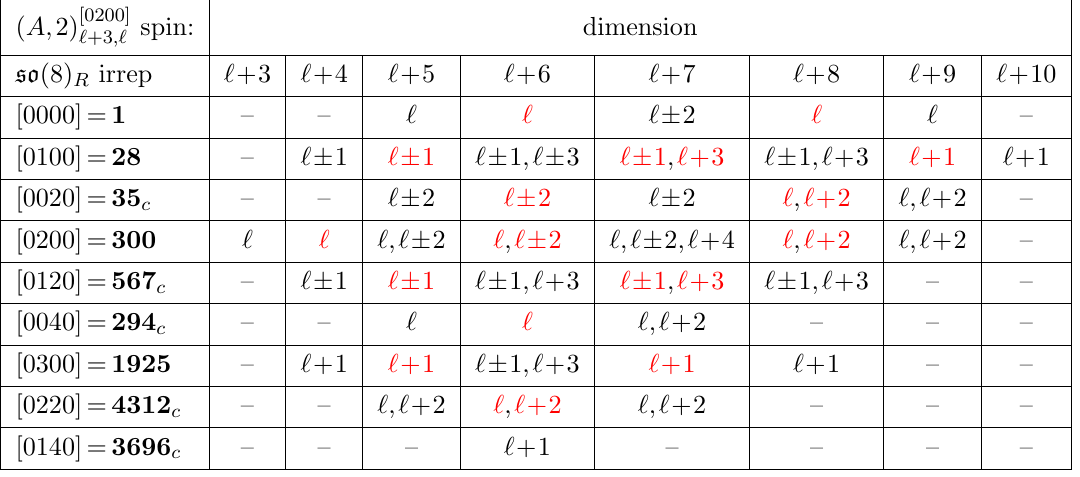
Table 28 . All possible conformal primaries in S 3 (cid:2) S 3 corresponding to the ( A; 2) [0200] formal